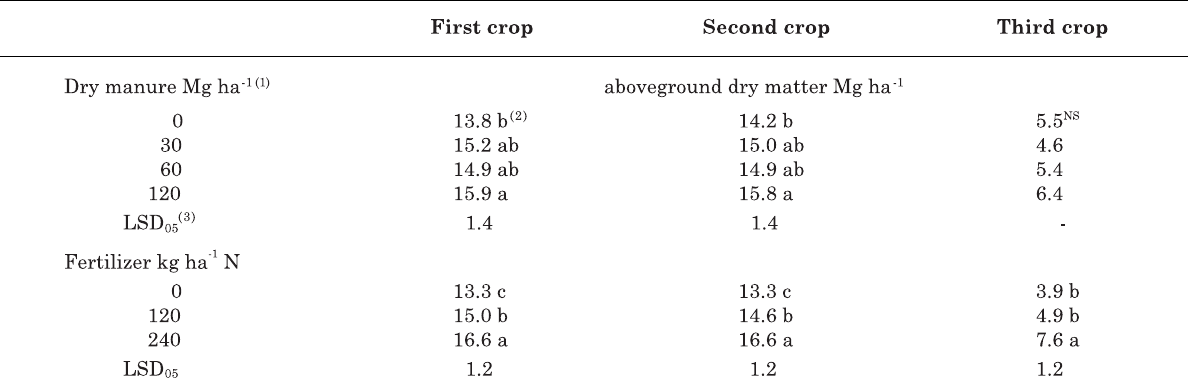
Table 1. Total dry aboveground matter production for the first (annual ryegrass), second (sudangrass) and third (annual ryegrass) forage crops grown under four manure and three fertilizer rates, labeled with 15